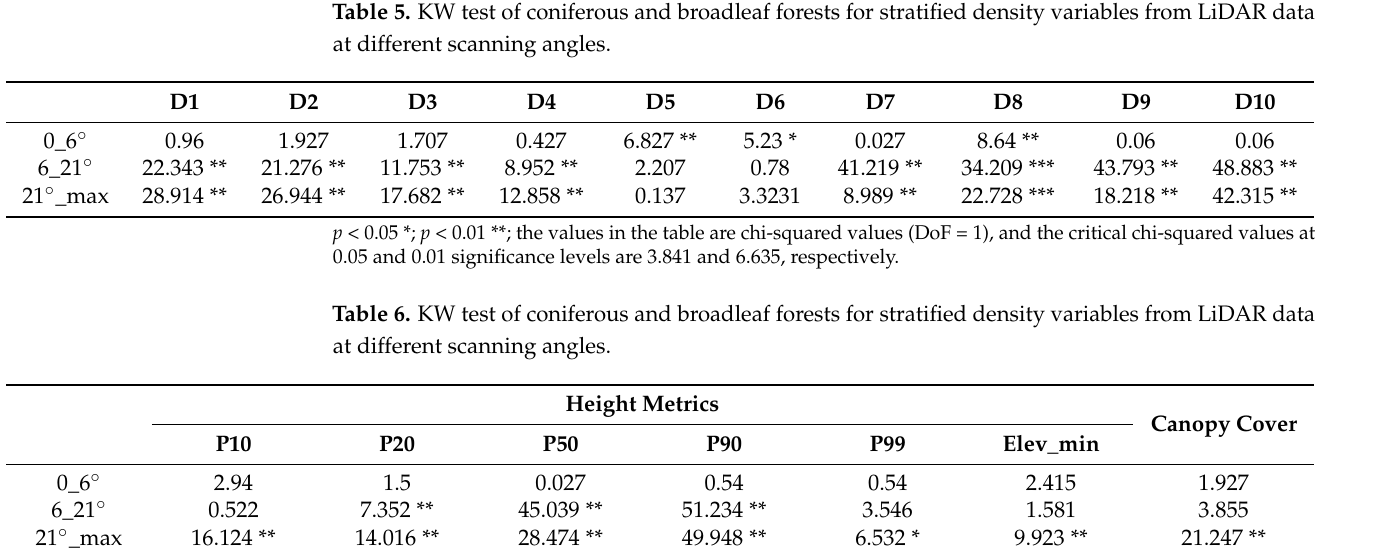
Figure 12. Statistics for the relative deviations ( a ) and standard deviations, and ( b ) of the angular effects change ratio. The regression equations in Equations (8)–(10) provide the coefficients among f(θ) , VV , and RD and the corresponding significance levels, and the test results indicated that no significant relationship existed between the percentile height variable and f(θ) or RD. The statistical correlations between the canopy characteristics and the stratified density factors and the canopy characteristics and the laser penetration height are shown in Tables 7 and 8, respectively. When the significant factors were combined, Sum3-4 displayed the most significant indirect effect (ab/c = +0.1051; p -value < 0.001) in the bootstrap test for D3, D4, D5, D6, and D9. The effects of the laser penetration heigh were found to be significant for D5, D6, D8, and D9, with the largest indirect effect observed for D9 (ab/c = − 0.78; p - value < 0.001). In general, the computation of ACI is indirectly influenced by the vertical gradient in all cases (Figure 13).